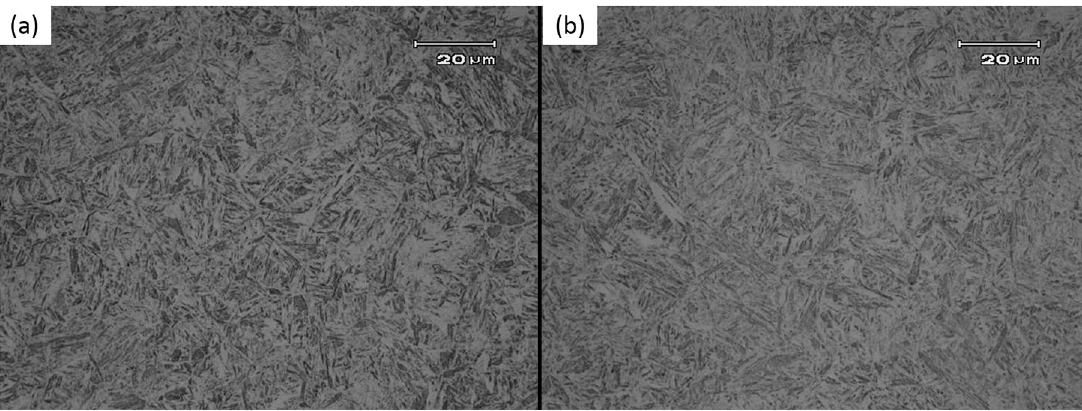
Figure 3. Microstructure of M2 material showing tempered martensite in; (A) longitudinal section; (B) transversal section. Nital 2%